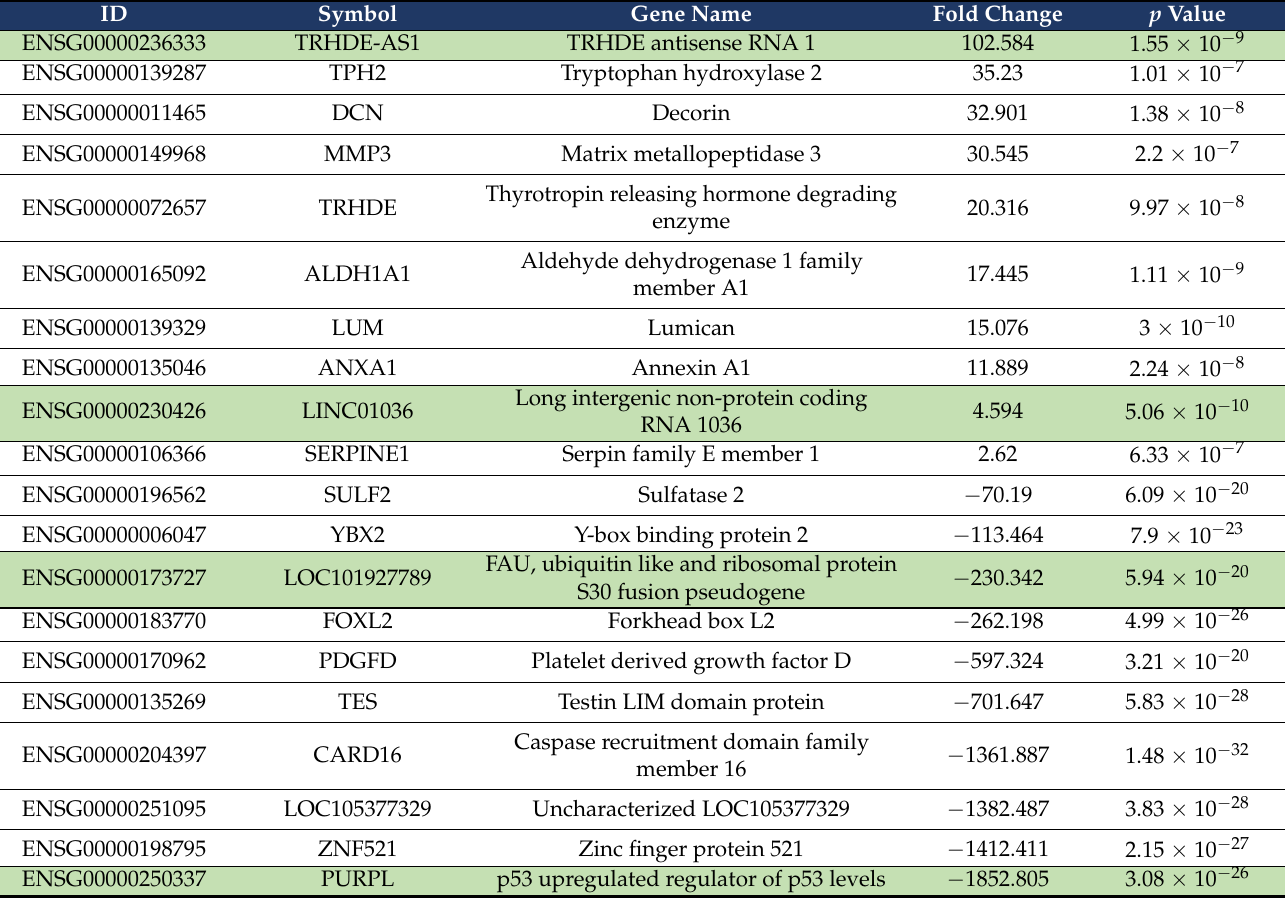
Table 3. Top 20 differentially expressed RNA transcripts in RBPMS SG2 vs. EV clones. Green: long-noncoding